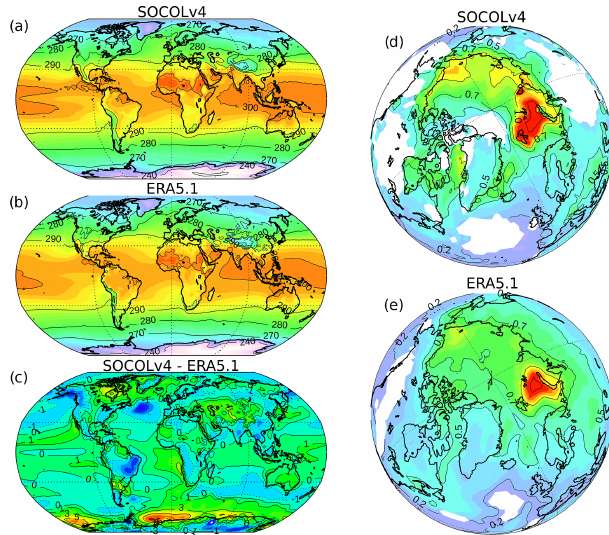
Figure 5. Left panels: global distribution of 2m surface air temper- ature (K, contours are − 5, − 3, − 1, 0, 1, 3, 5, 7, 9) averaged over the period 1980–2018 simulated by SOCOLv4 ( a , ensemble mean), ERA5.1 reanalysis data (b) , and their difference ( c , SOCOL4- ERA5.1). Right panels: 2m surface air temperature trend over the Northern Hemisphere (K/10 years, contours are − 0.5, − 0.2, 0, 0.2, 0.5, 0.7, 1.0, 1.5) simulated (d) and observed (e) over the Northern Hemisphere. White spots show where the trend is not statistically significant at the 95%